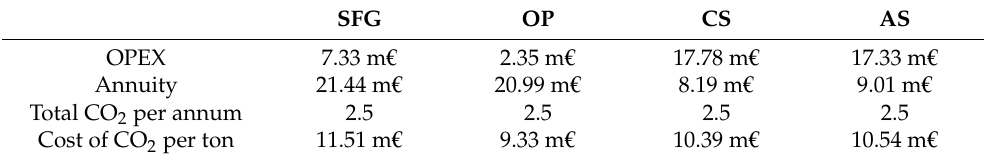
Table A10. Competition costs per ton of CO 2 for different vessels (180 km and 2.5 mtpa